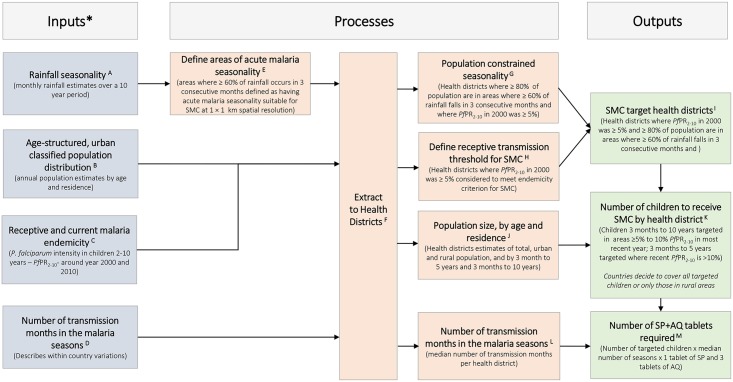
A spatial decision support framework for identifying areas suitable for seasonal chemoprevention and quantifying the size of the population of target children and the amount of the required antimalarial tablets.For additional details of the definition of inputs, processes and outputs see the S1 File.